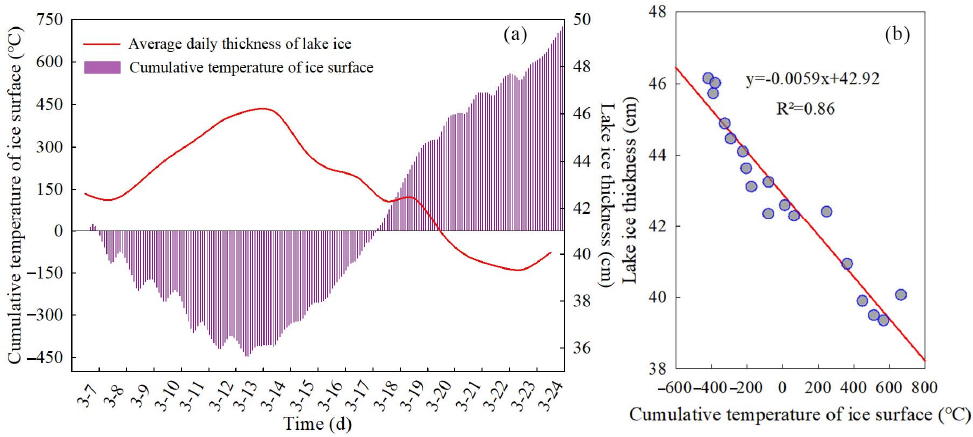
Figure 9. Relations among the average daily thickness of lake ice, the cumulative temperature of ice surface ( a ), and average daily cumulative temperature of ice surface ( b ).